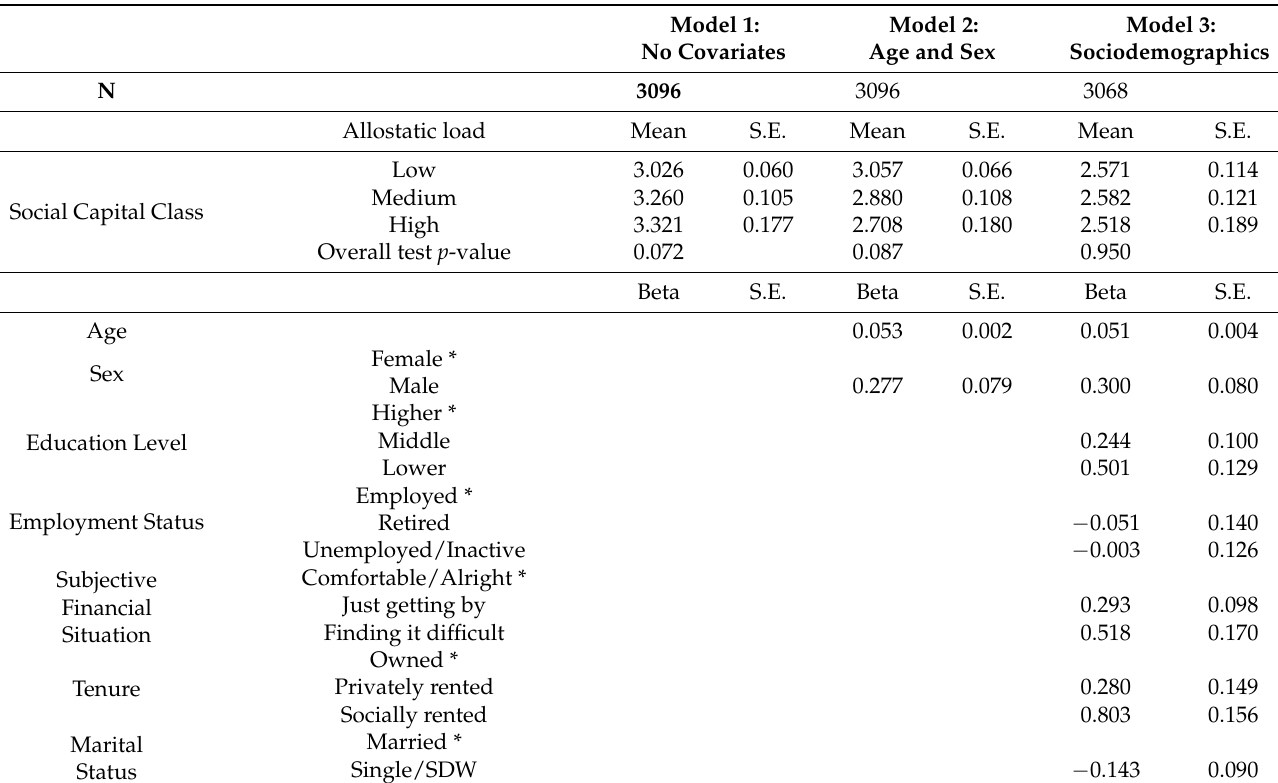
Table 5. Estimated allostatic load means by social capital history and covariate coefficients predicting allostatic load. Model 1: Model 2: Model